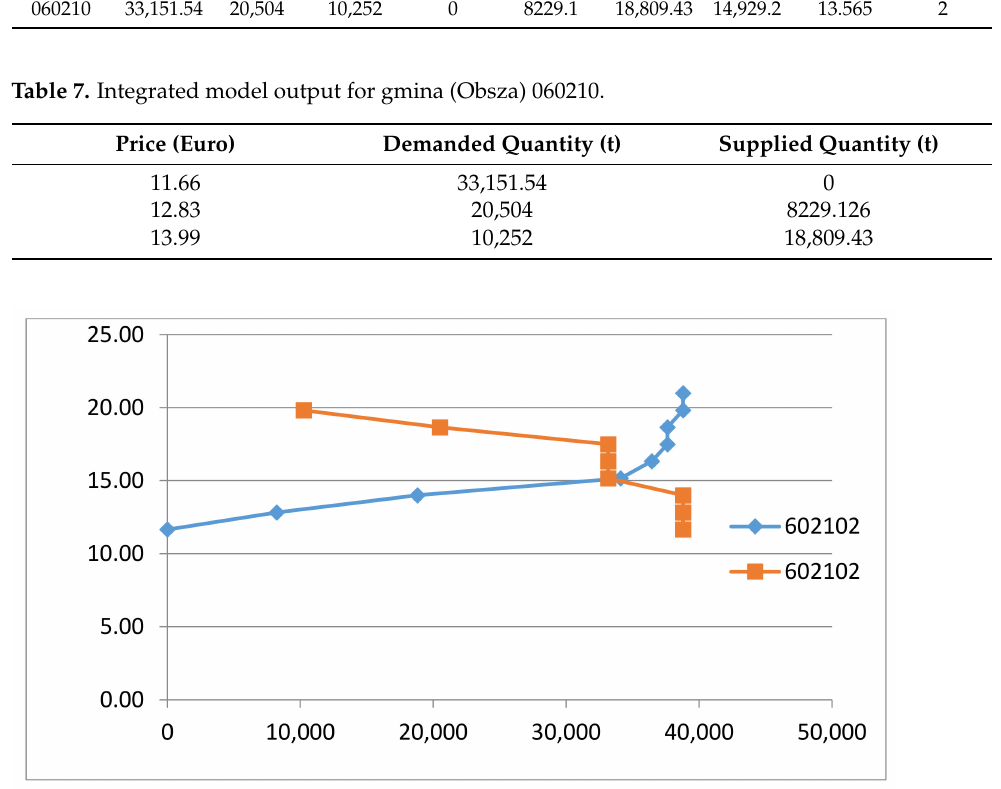
Figure 6. Supply and demand in a gmina ( € /t against kg)—602102: